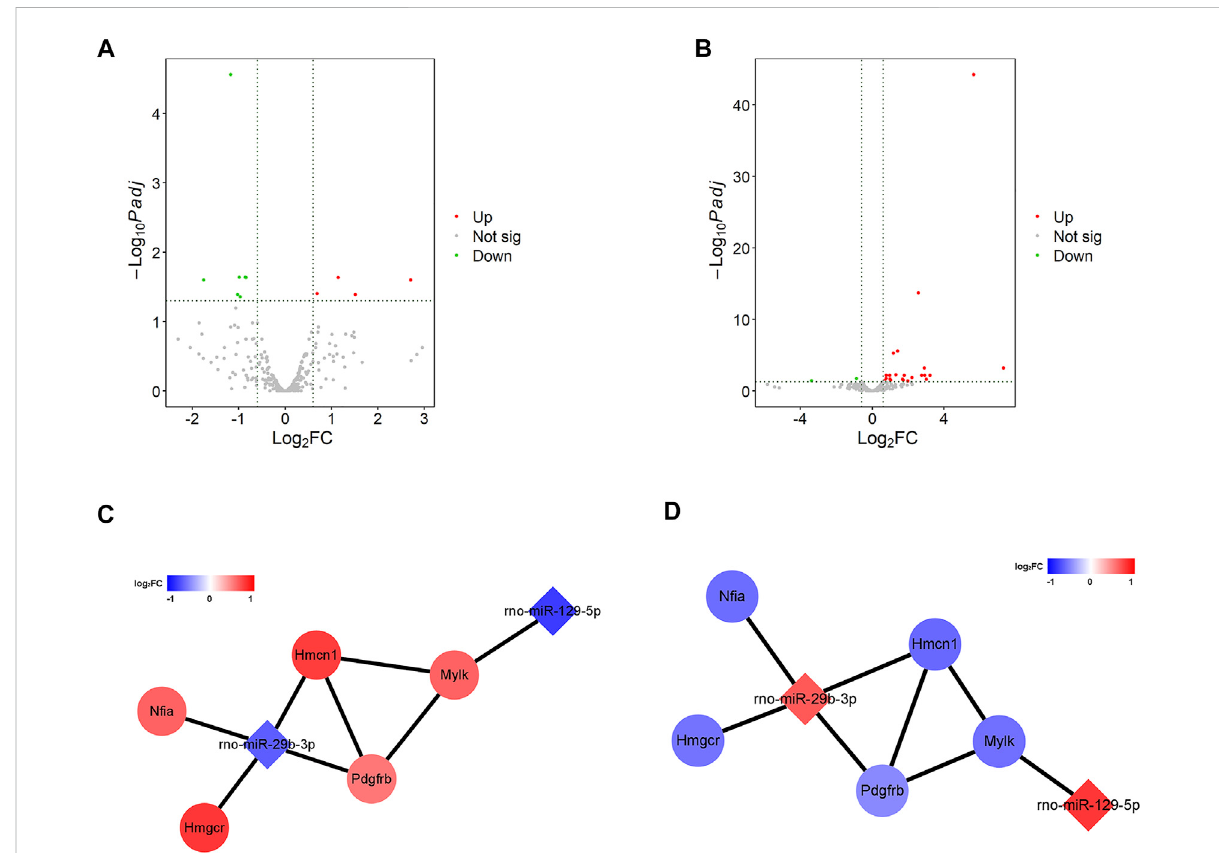
FIGURE 2 ARS systematically alters the gene expression pro fi le of H9c2 cells. (A , B) The volcano plot of signi fi cant DEmiRNAs; (C , D) The miRNA-mRNA network.